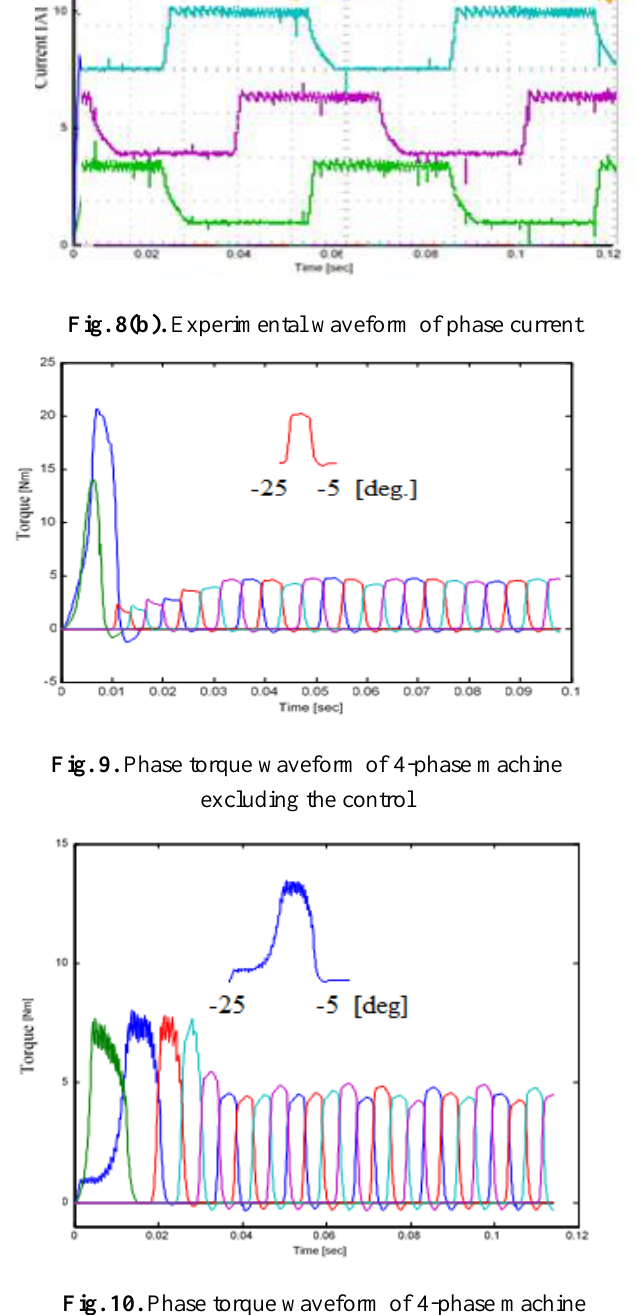
Fig. 10. Phase torque waveform of 4-phase machine including the control i.e. current chopping